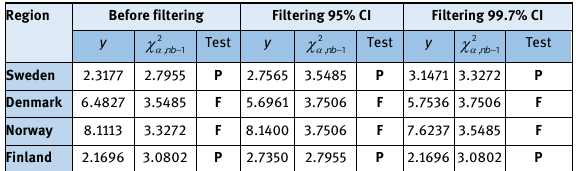
Table 1. Chi-square goodness-of-fit test of normality before and after filtering based on two confidence intervals of 95% and 99.7%, P and F stand for pass and fail, respectively [unitless] Region Before filtering Filtering 95% CI